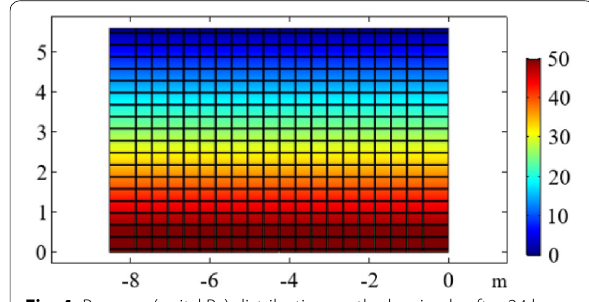
Fig. 4 Pressure (unit: kPa) distribution on the barricade after 24 h stope filling.